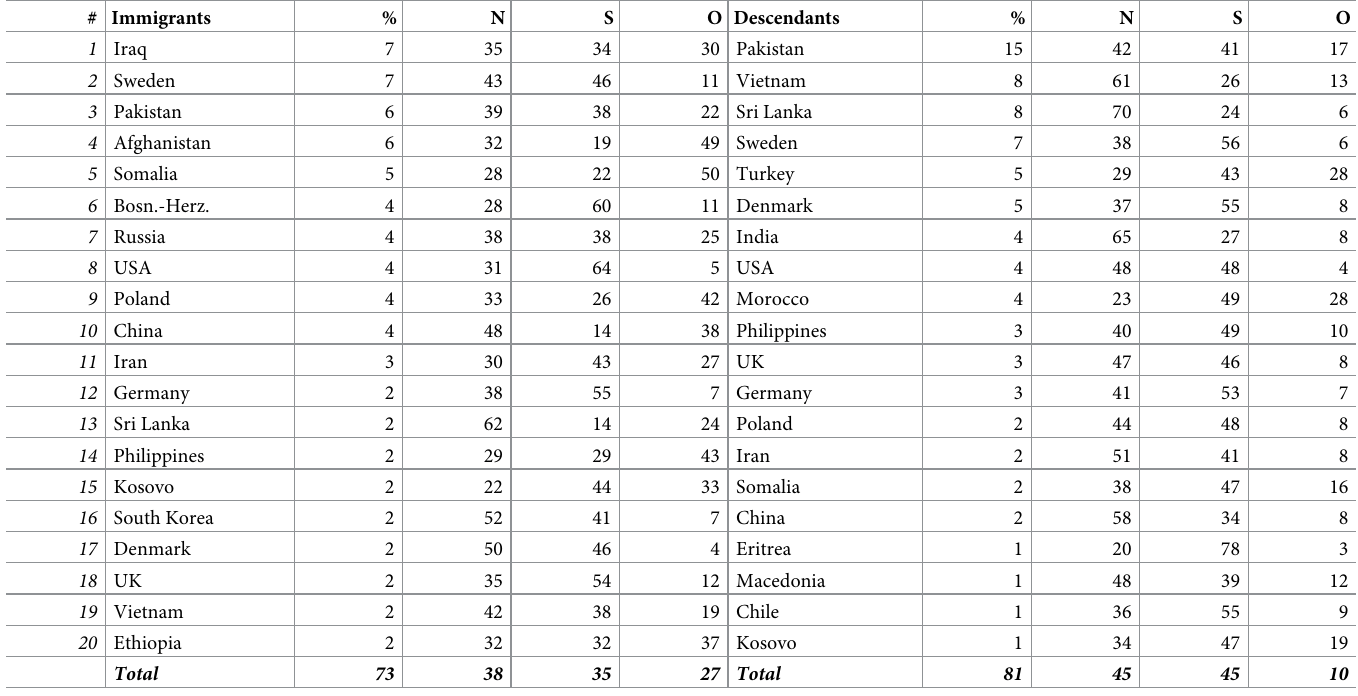
Table 3. Origins of immigrants and descendants. The twenty most common countries of origin for immigrants and mother’s origin for native descendants, with propor- tional share in the population from the country, and share of students on the specialisation tracks natural science (N); language, social science and economy (S); and other (O), respectively. The total is the summed share from the twenty most common countries, and shares in the whole set of immigrants and descendants, respectively, on the respective specialisation tracks. Note that school classes with too few immigrants to perform our analyses have been excluded. Including the whole population, not only those in our analysis, would increase the figures for “other” specialisations. All figures are in percent. #